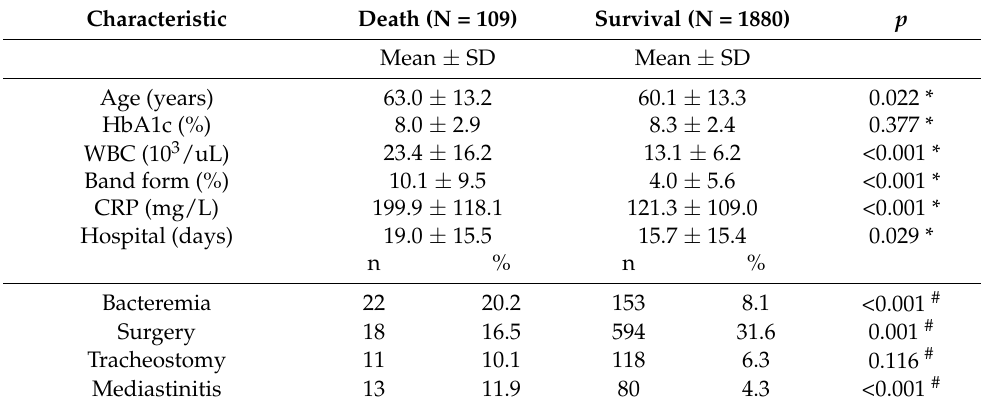
Table 5. Analysis of characteristics between the death and survival subgroups of T2DM-DNI. Characteristic Death (N = 109) Survival (N = 1880) p Mean ± SD Mean ± SD Age (years) 63.0 ± 13.2 60.1 ± 13.3 0.022 * HbA1c (%) 8.0 ± 2.9 8.3 ± 2.4 0.377 * WBC (10 3 /uL) 23.4 ± 16.2 13.1 ± 6.2 <0.001 * Band form (%) 10.1 ± 9.5 4.0 ± 5.6 <0.001 * CRP (mg/L) 199.9 ± 118.1 121.3 ± 109.0 <0.001 * Hospital (days) 19.0 ± 15.5 15.7 ± 15.4 0.029 * n % n % Bacteremia 22 20.2 153 8.1 <0.001 # Surgery 18 16.5 594 31.6 0.001 # Tracheostomy 11 10.1 118 6.3 0.116 # Mediastinitis 13 11.9 80 4.3 <0.001